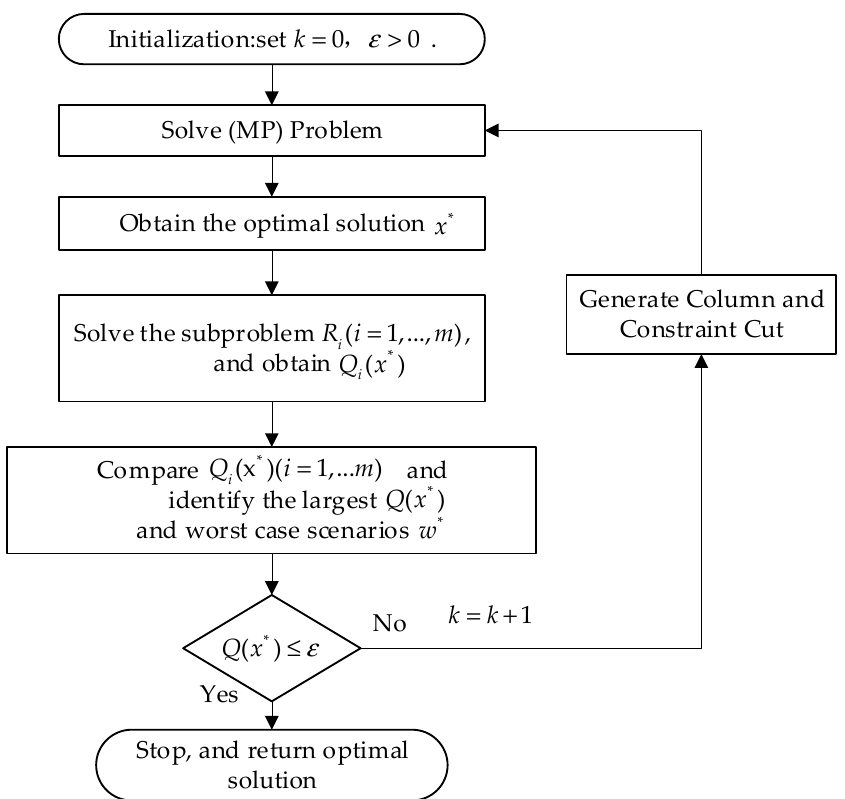
Figure 2. Flowchart of the proposed solution algorithm.